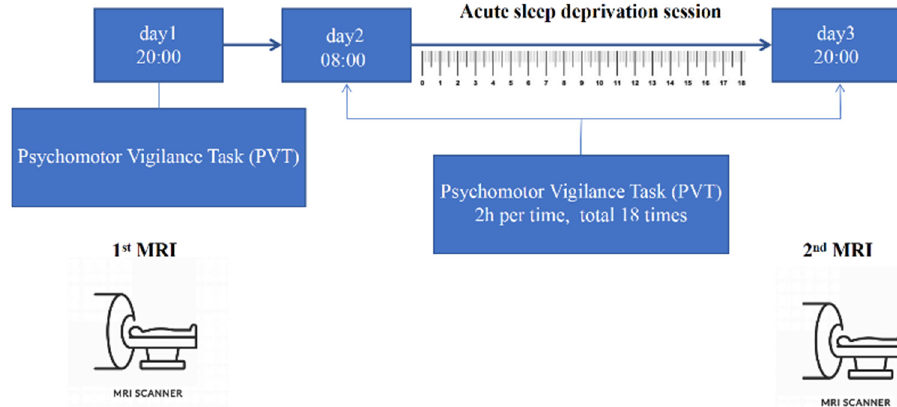
Figure 1. Experimental paradigm of the study.